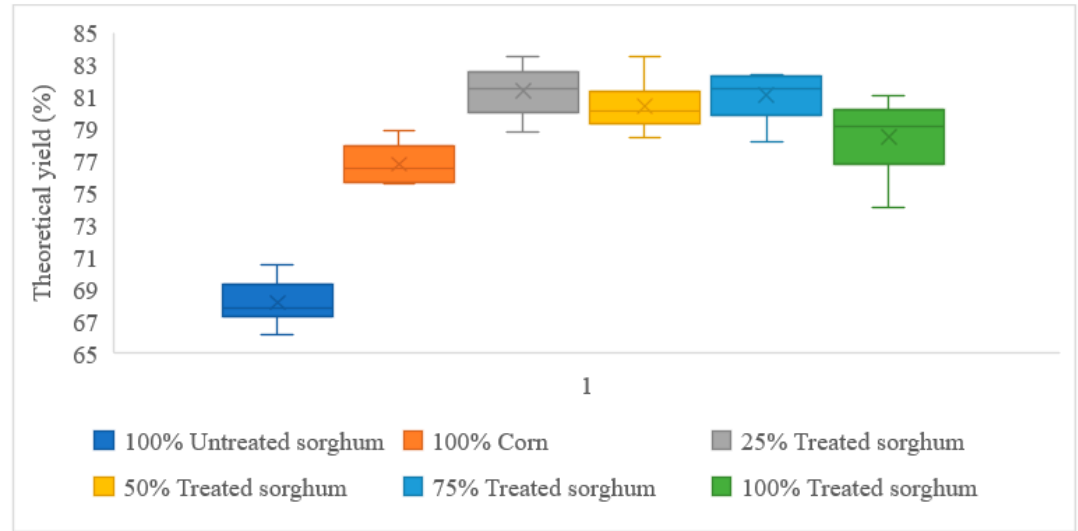
Figure 2. Theoretical yield of non-cellulase fermentations.